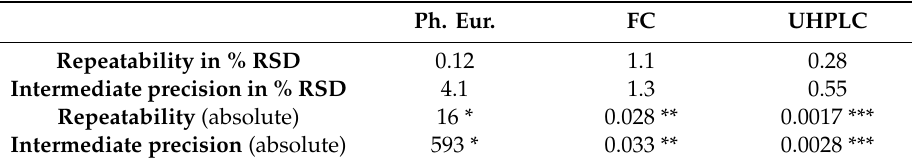
Table 2. Parameters of the precision studies of the reference